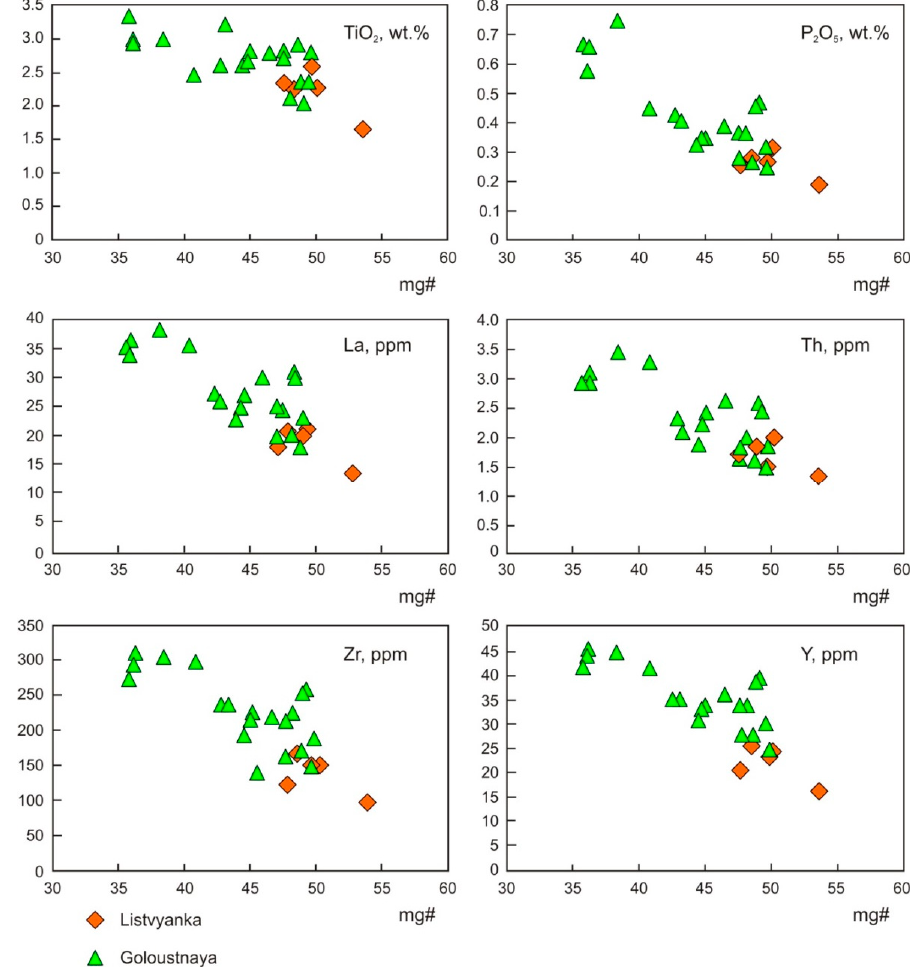
Figure 6. Variation of TiO 2 , P 2 O 5 , La, Th, Zr and Y with magnesium number, mg# for Listvyanka and Goloustnaya dolerites.